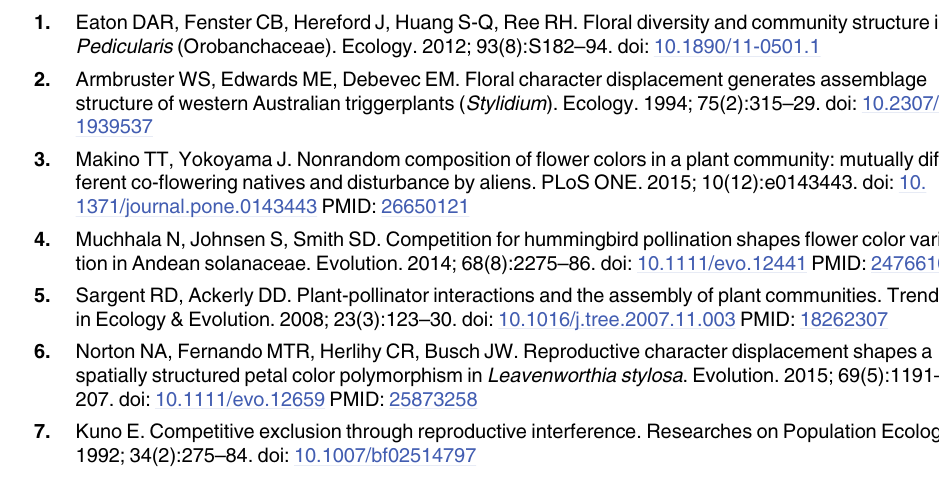
S1 Table. Study sites and sample size for each analysis. S2 Table. Summary of morphologicaldata